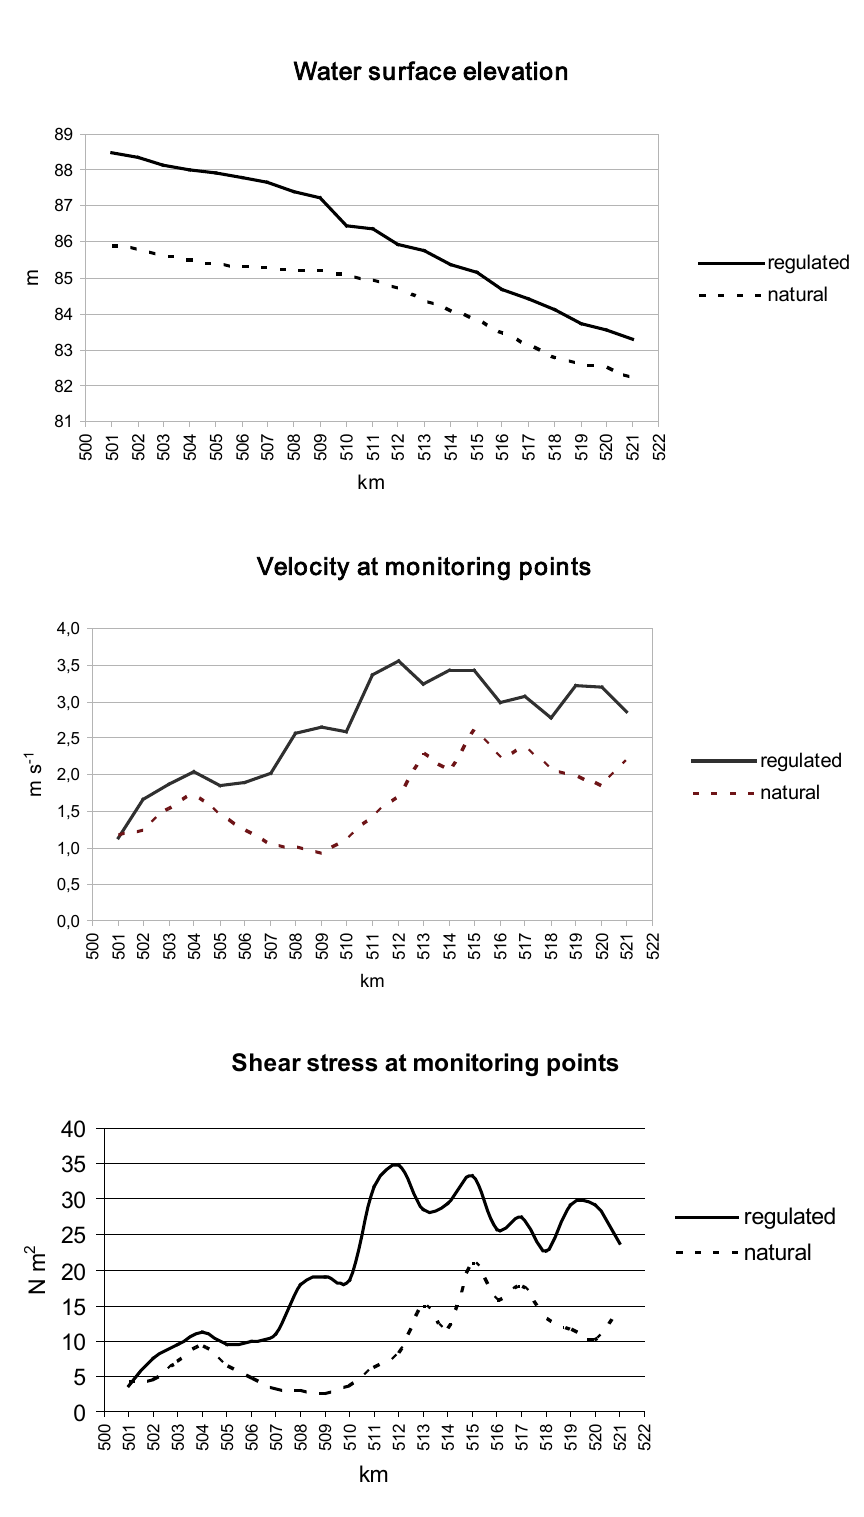
Fig. 4 Comparison of the hydraulic parameters of the Vistula River in Warsaw, corresponding to natural and regulated flow